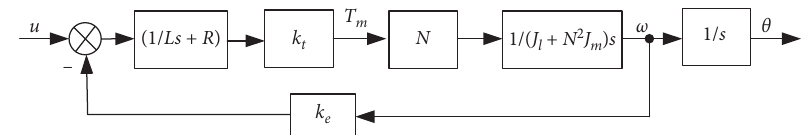
Figure 3: Control diagram of torque motor on gimbal.